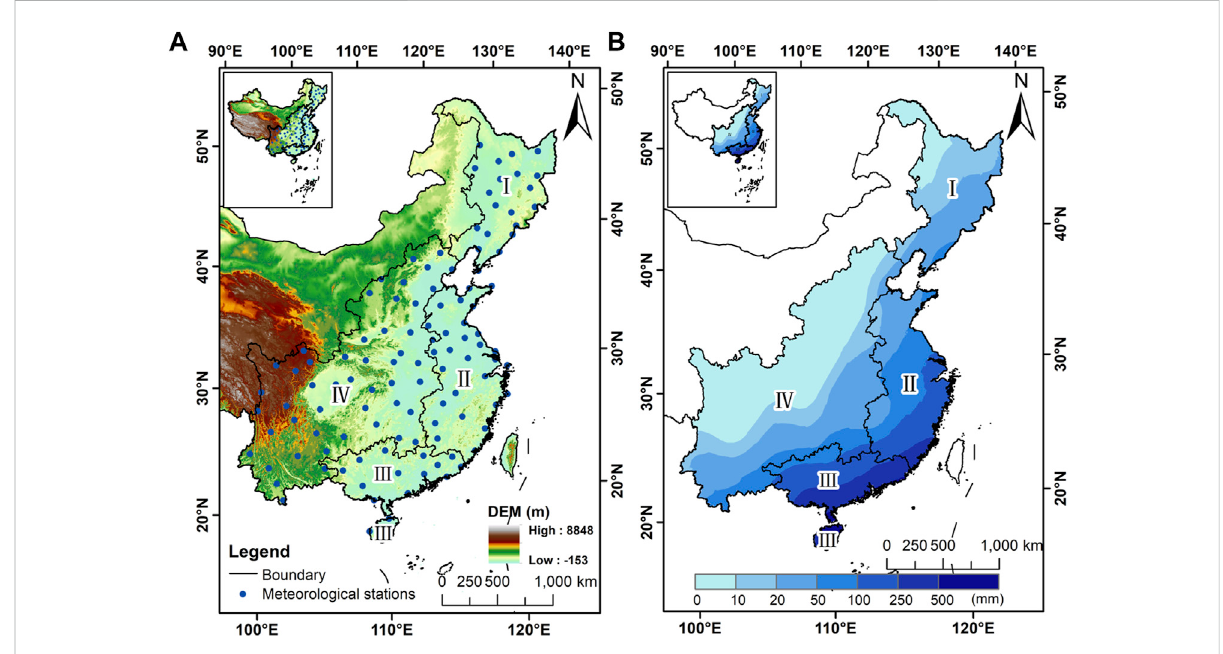
FIGURE 1 Study area information. (A) Meteorological stations and topography. (B) Distribution of the mean annual TCP over